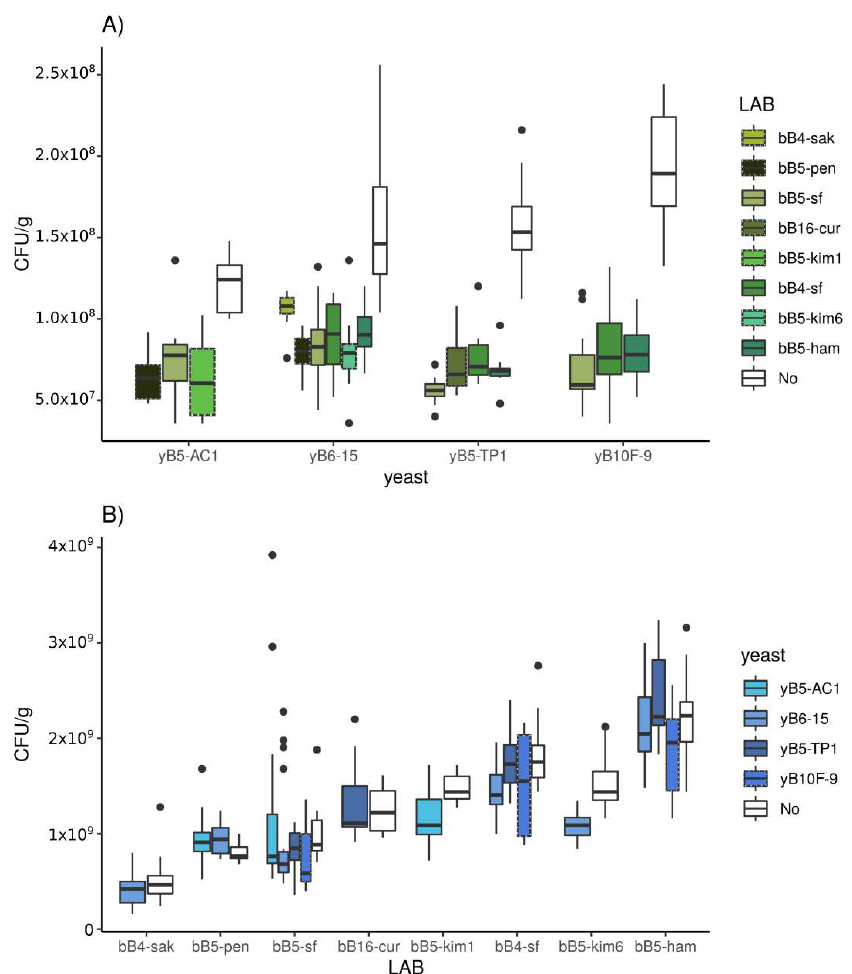
Figure 4. Colony forming units per gram of dough (CFU / g) for ( A ) yeast strains in monoculture and coculture with LAB and ( B ) LAB strains in monoculture and coculture with yeast, measured after 24 h. CFUs / g in monoculture are presented in white-filled boxes. Green indicates LAB, with obligately heterofermentative LAB strains in a plain lined boxplot. Blue indicates yeast, with S. cerevisiae in dashed boxplots and K. humilis in a plain lined boxplot.